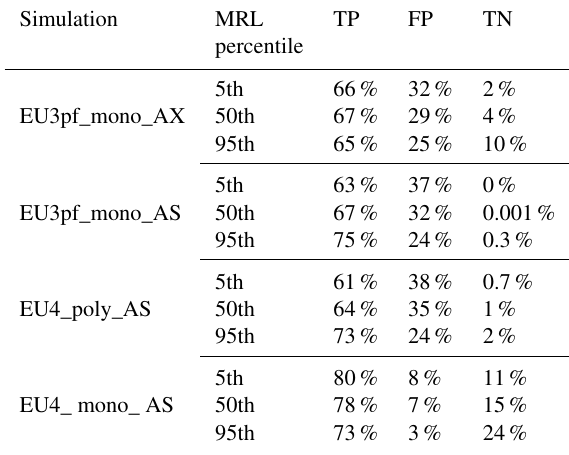
Table 5. True positive (TP), false positive (FP) and true negative (TN) instances of the simulations in Fig.